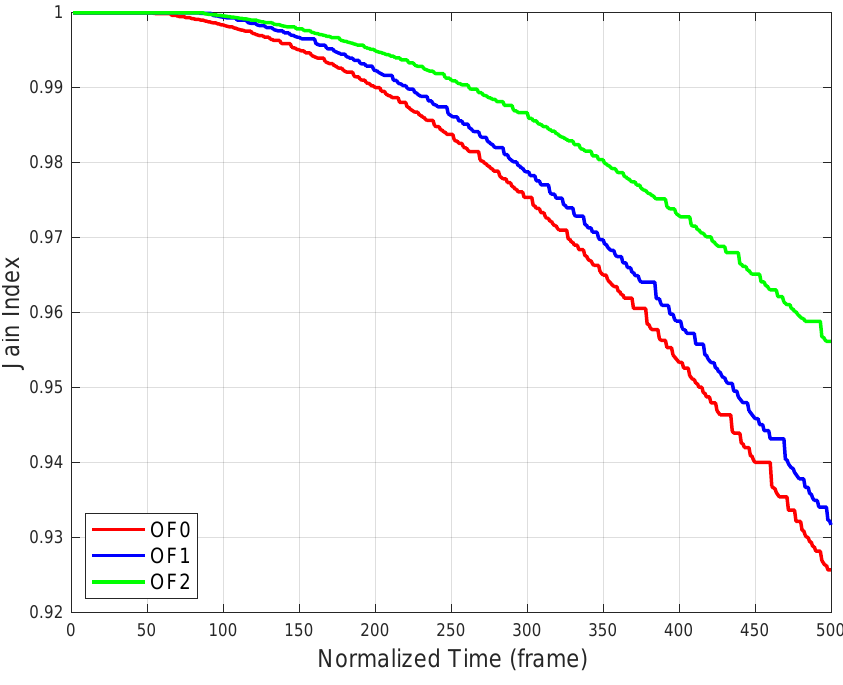
Figure 6. Jain’ index of the residual normalized battery level as a function of time for the considered RPL Objective